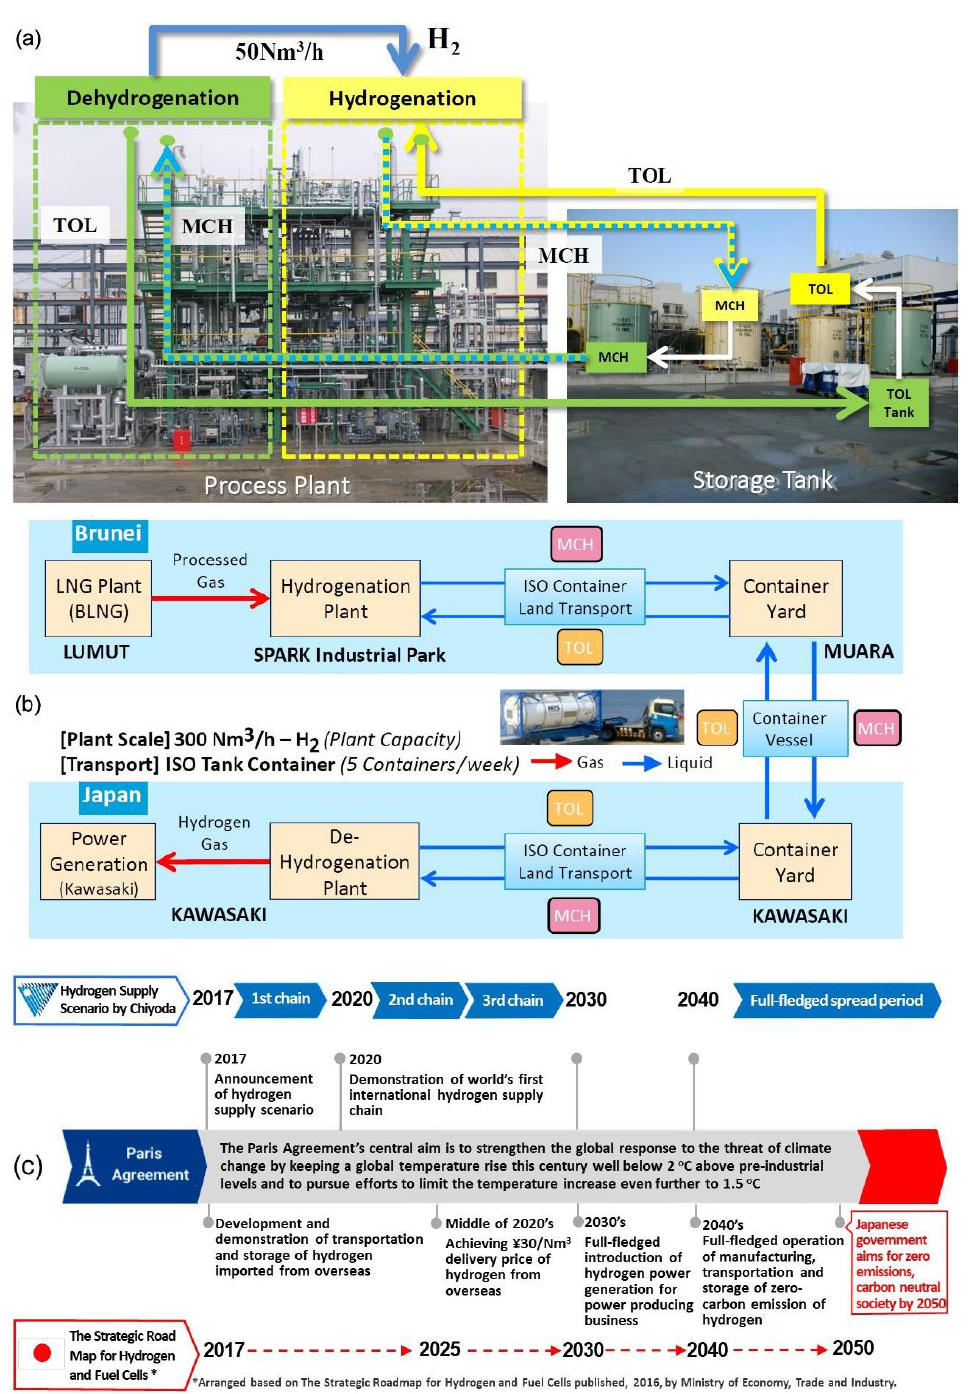
Figure 8. Recent initiatives taken by a consortium of some Japanese companies for transportation, storage and production of hydrogen at commercial scale based on MCH-TOL system. ( a ) Pilot scale hydrogenation and dehydrogenation plants developed by Chiyoda, Japan; ( b ) block diagram showing components of MCH-TOL based international hydrogen supply chain between Brunei and Japan; ( c ) Chiyoda’s roadmap for hydrogen supply. Adapted from [31] with permission.